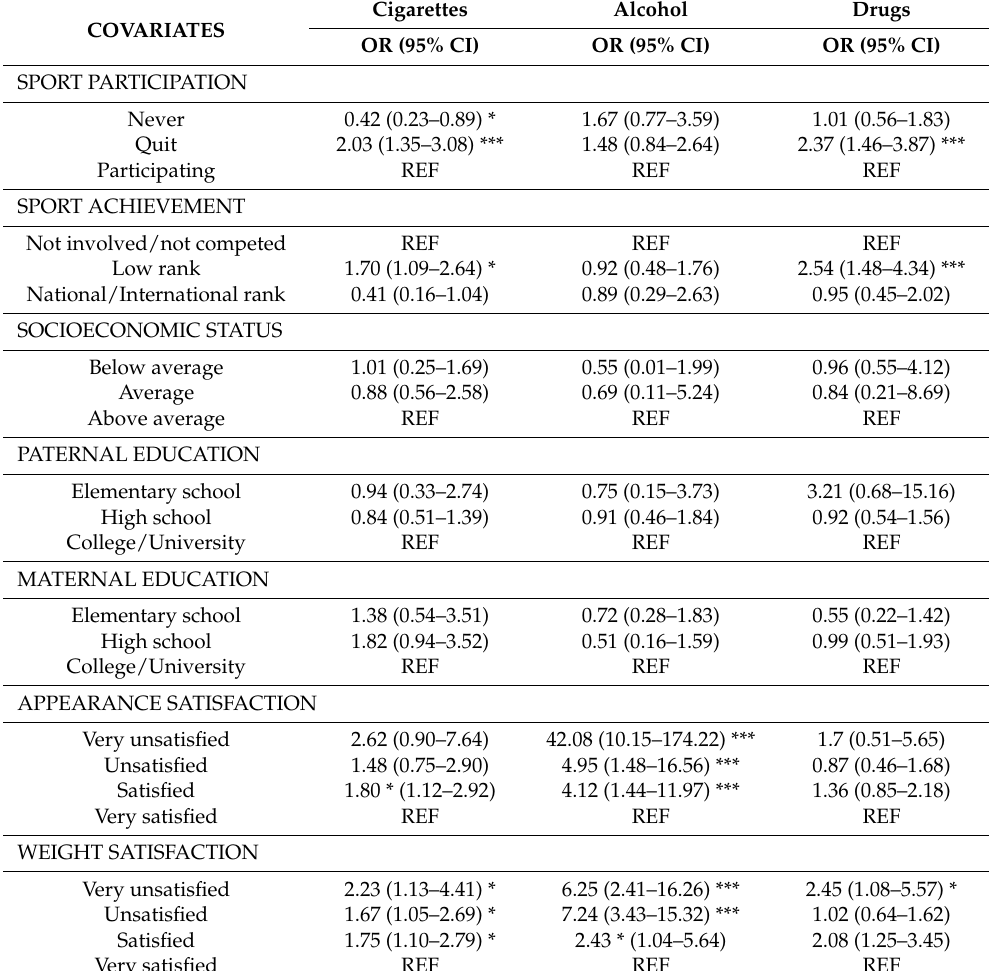
Table 1. Logistic regression calculations for Croatian